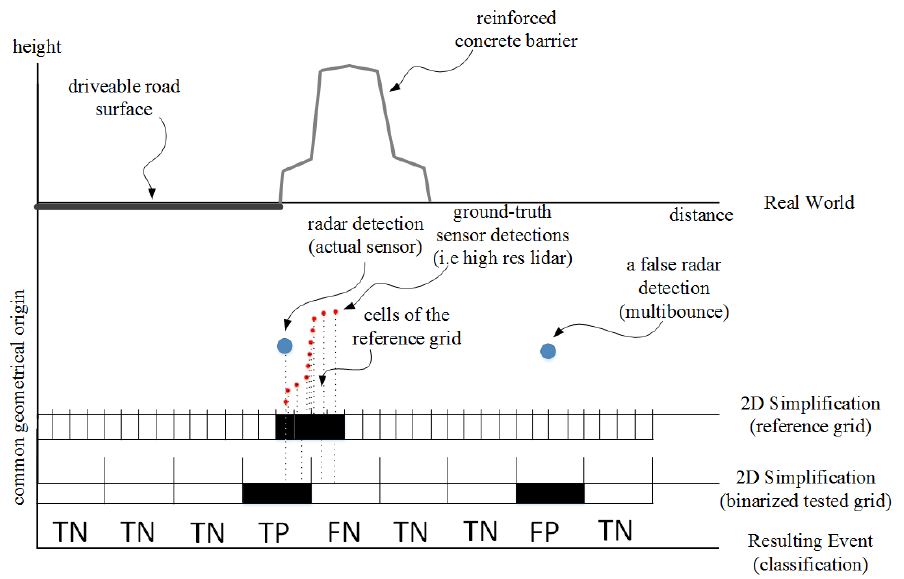
Figure 10. Drawing of the 1D simplification of the reference data generation and comparison with the high resolution reference data along with the resulting event classification for the performance